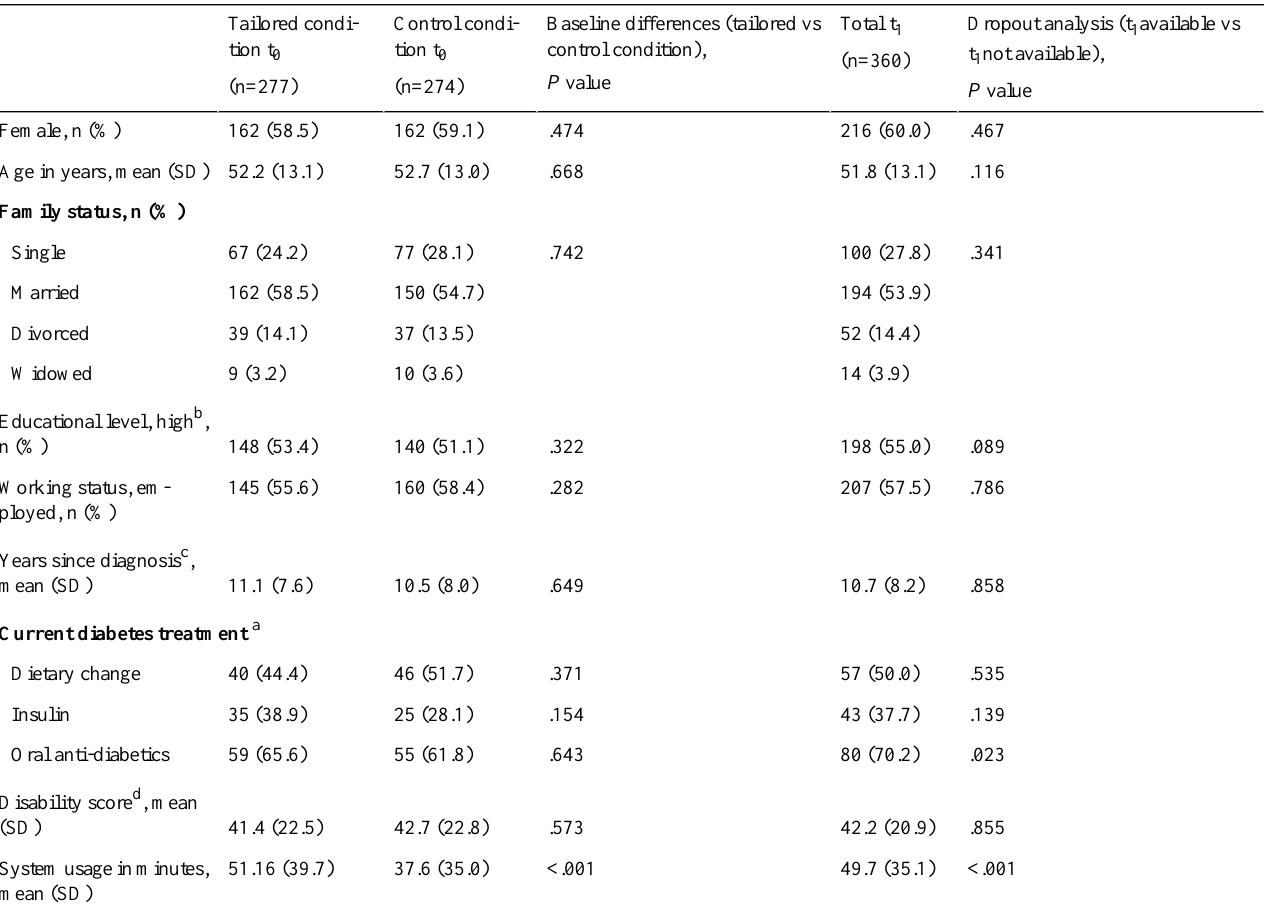
Table 4. Sample characteristics a .